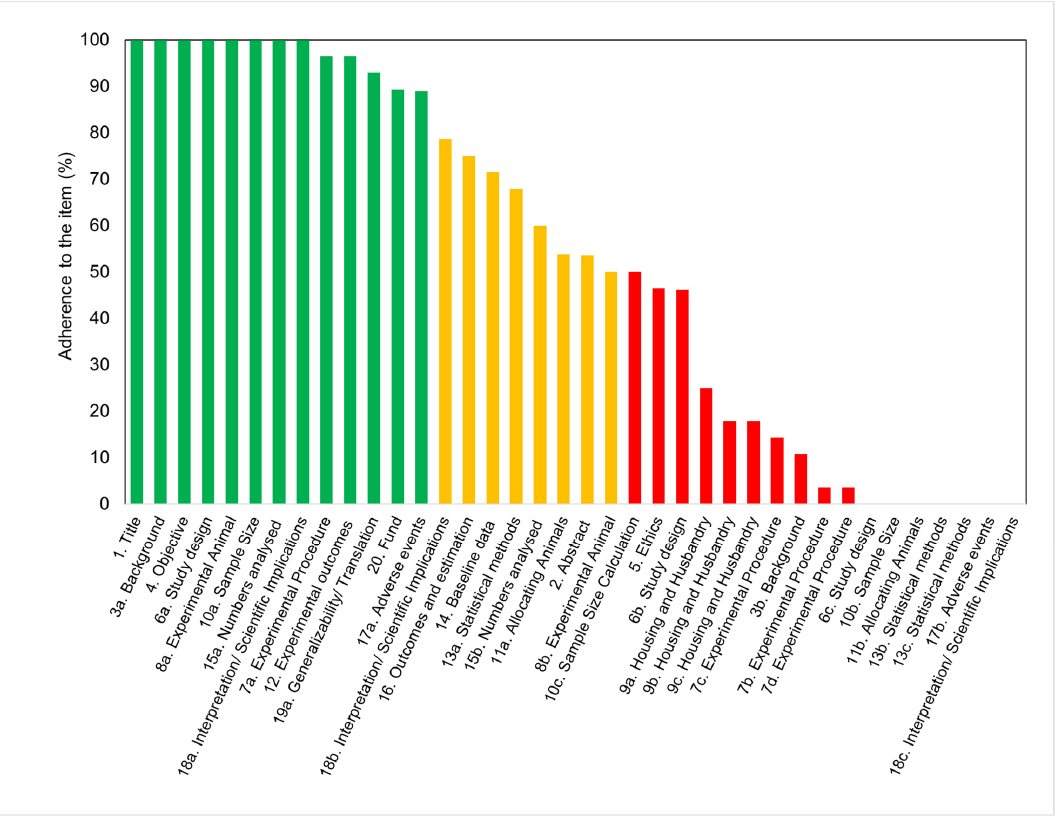
Figure 5. Bar chart showing the degree of adherence (in %) to the 38 items in the ARRIVE checklist. The data were clustered to display the items in which studies had a high degree of adherence (between 80 and 100%, in green), medium degree of adherence (between 50 and 79%, in yellow), and low degree of adherence (0 to 49%, in red). Items are indicated by their corresponding numbers and a label associated with their content.